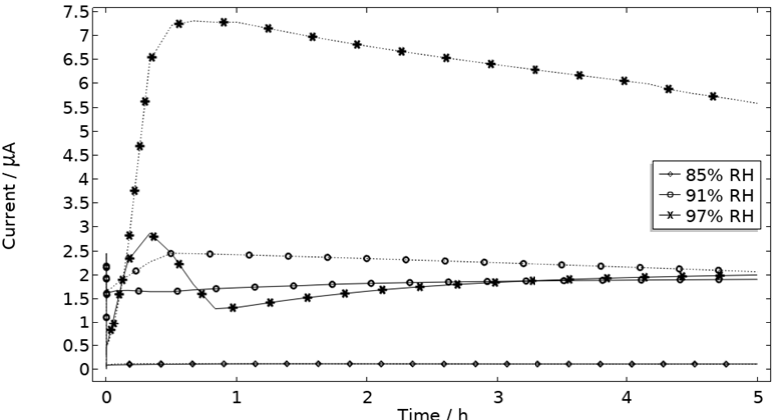
Figure 17. Galvanic current during 5 h exposure of the calibration cell with 86 μg NaCl/cm 2 load at 21 °C at 85%, 91%, and 97% RH. Solid line indicates with presence of Al(OH) 3 (s) and dotted line without presence of Al(OH) 3 (s).